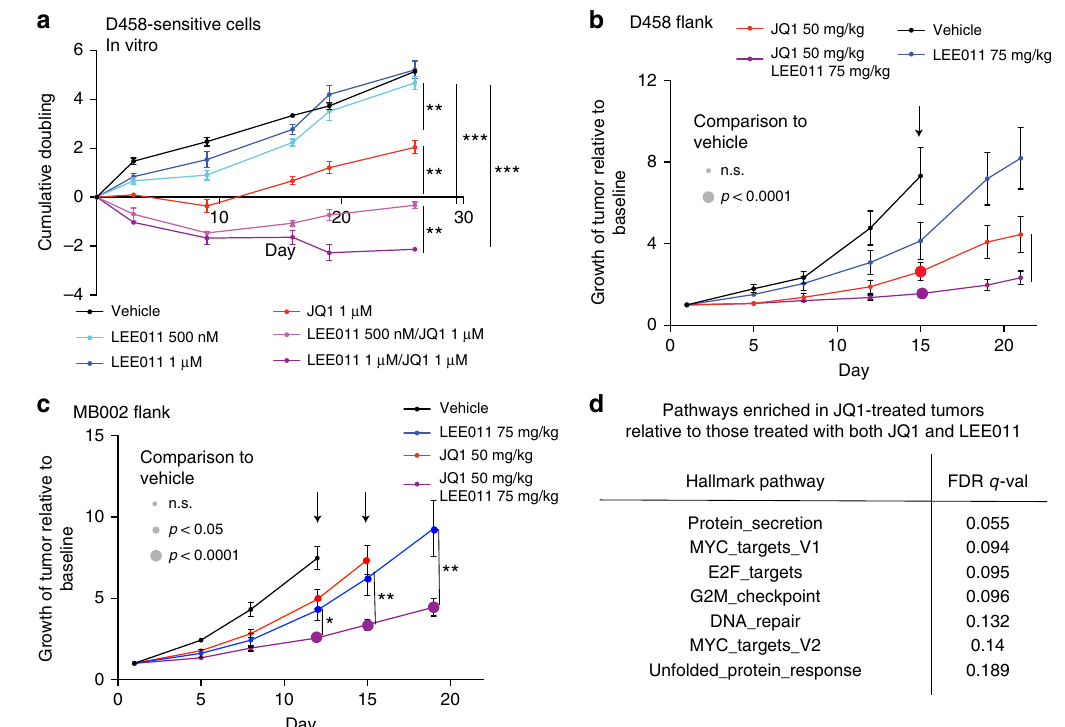
Fig. 8 Combination of BETi and CDK4/CDK6 attenuates resistance in fl ank models a Cumulative doubling of D458 cells passaged in DMSO, LEE011 (500 nM or 1 μ M), JQ1 (1 μ M) or the combination of JQ1 (1 μ M) with LEE011 at either 500 nM or 1 μ M. Data from three independent replicates are shown, error bars depict mean ± SEM. For all panels, asterisks denote statistically signi fi cant differences (* p < 0.05, ** p < 0.01, *** p < 0.001) as determined by two-tailed unpaired t -tests. Source data: Source Data File. b Growth of D458 fl ank xenografts treated with vehicle, JQ1 (50 mg/kg/day), LEE011 (75 mg/kg/day) or the combination of both compounds (JQ1 50 mg/kg/day and LEE011 75 mg/kg/day). Three vehicle treated mice were euthanized on day 15 due to their tumor size (shown by arrow). Data represent mean tumor volume ( n = 10), normalized to day 1, ± SEM. Large circles denote time points with signi fi cant ( p < 0.0001) improvement in tumor volume relative to DMSO controls. Asterisk denotes signi fi cant ( p < 0.05) improvement in tumor volume among mice treated with JQ1 and LEE011 relative to those treated with JQ1 alone as determined by two-tailed unpaired t -tests. Source data: Source Data File. c Growth of MB002 fl ank xenografts treated with vehicle, JQ1 (50 mg/kg/day), LEE011 (75 mg/kg/day or the combination of both compounds (JQ1 50 mg/kg/day and LEE011 75 mg/kg/day). Arrows depict days in which mice were euthanized due to their tumor size. Data represent mean tumor volume ( n = 10), normalized to day 1, ± SEM. Medium and large circles denote signi fi cant ( p < 0.05 and p < 0.0001, respectively) differences between treated tumors at each time point relative to DMSO controls. Asterisks denote statistically signi fi cant improvements in tumor volume among mice treated with JQ1 and LEE011 relative to those treated with JQ1 alone (* p < 0.05, ** p < 0.01, *** p < 0.001) as determined by two-tailed unpaired t -tests. Source data: Source Data File. d Gene sets enriched in mRNA extracted from in vivo D458 fl ank xenografts treated with JQ1 relative to xenografts treated JQ1 and LEE011 (and thus suppressed by the combination of JQ1 and